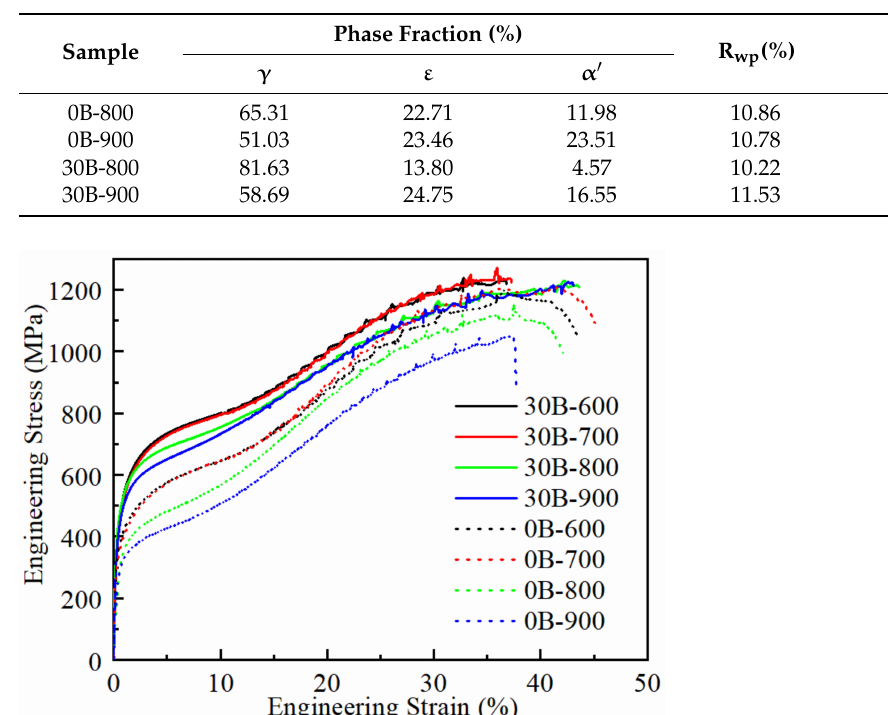
Table 3. Phase fractions of annealed samples with multiple phases according to XRD.